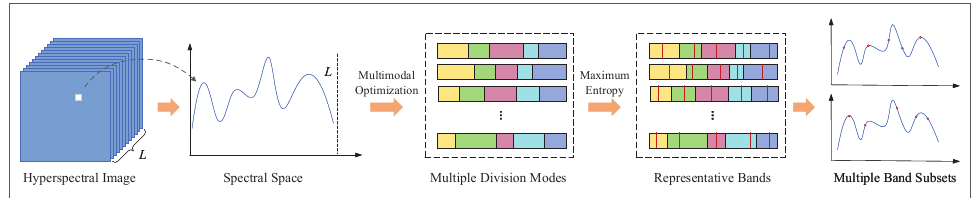
Figure 1. Overall procedure of the proposed